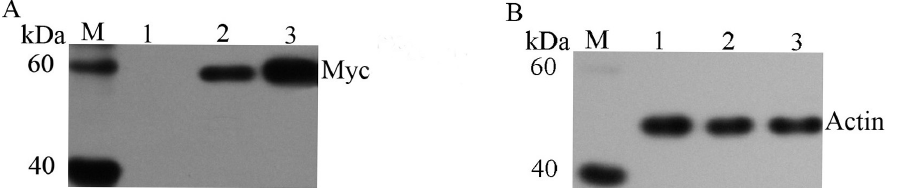
Figure 2. CYP1A4 and CYP1A5 expressed in HeLa cells. PcDNA-CYP1A4, pcDNA-CYP1A5 and empty vector were transformed into HeLa cells, and their transformants were confirmed by Western blotting using the myc-antibody ( A ) and actin-antibody ( B ). M: marker; 1: HeLa-pcDNA; 2: HeLa-CYP1A4; 3: HeLa-CYP1A5.